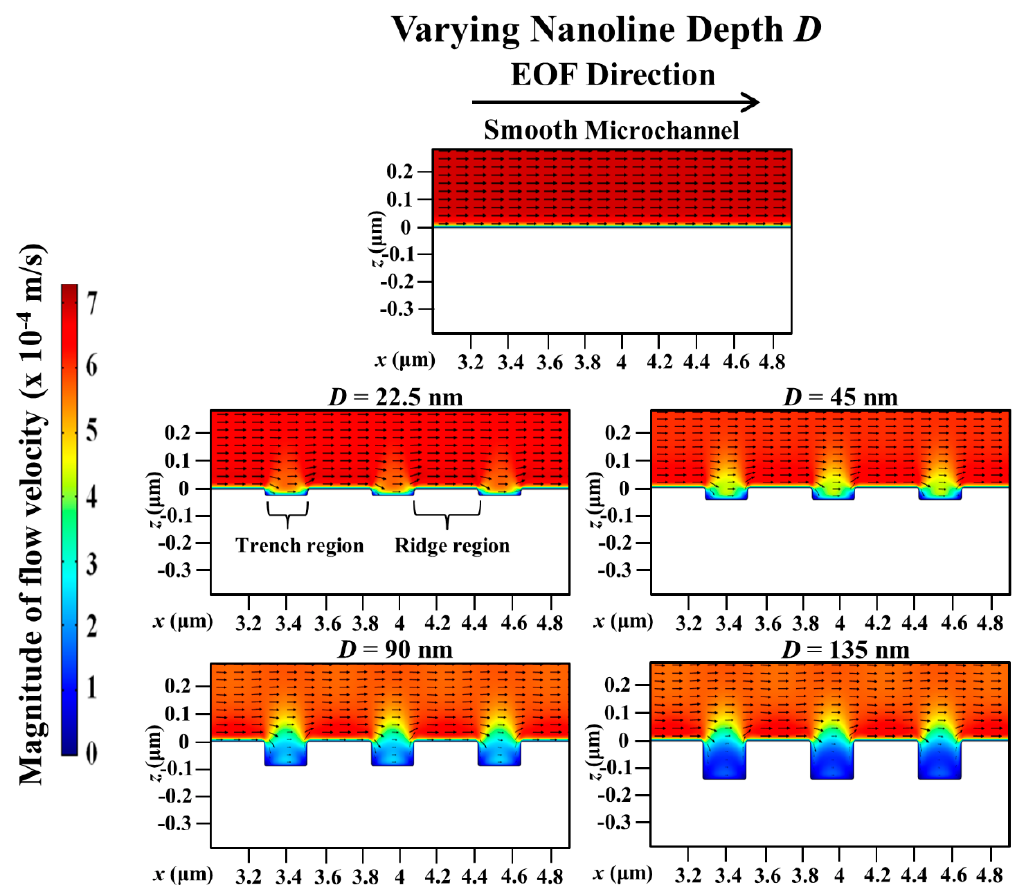
Figure 10. Simulated electroosmotic flow (EOF) velocity profile in microchannel with varying nanoline depth D , in comparison to smooth microchannel. Sodium bicarbonate (NaHCO 3 ) concentration was fixed at 1.0 mM, and nanoline orientation angle θ , width W , and period P were fixed at 45°, 160 nm, and 400 nm, respectively. When D increases, EOF profile is more asymmetric due to more electric field distortion in the trench. As D gets deeper, EOF profile changes insignificantly as the electric field stays negligibly weak in the trench for driving EOF.